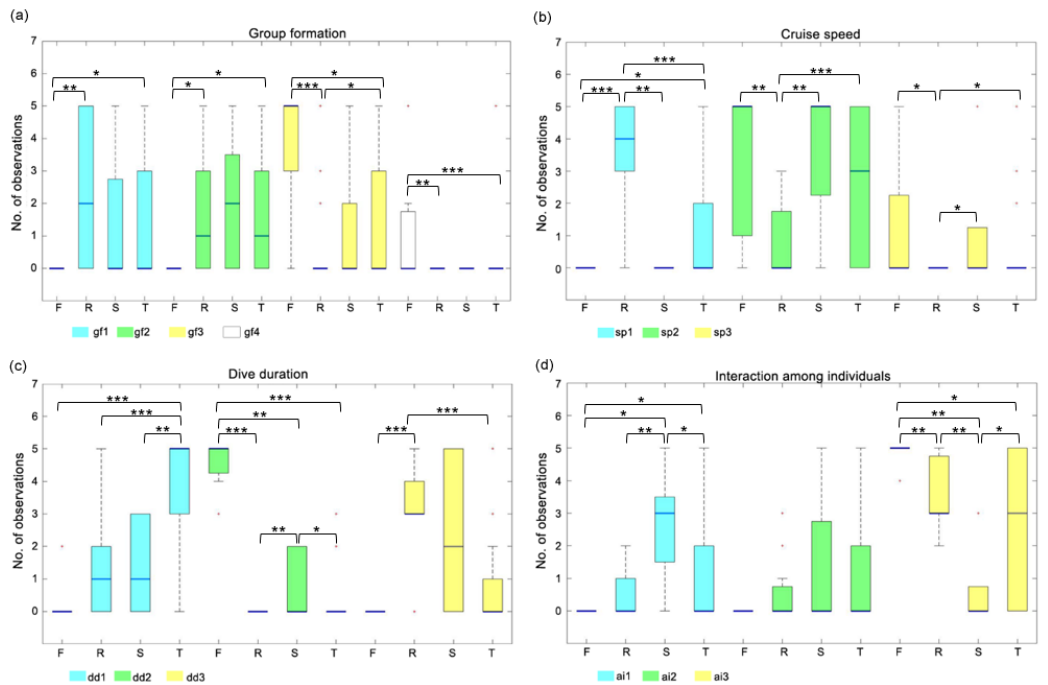
Figure 3. Box plot of the number of observations for each group composition variables: ( a ) group formation (gf), ( b ) cruise speed (sp), ( c ) dive duration (dd) and ( d ) interaction between animals (ai) considering each activity state. The blue bold line is the median value; box limits are quartiles; whiskers represent minimum and maximum values and small red points identify outliers. Significant differences found are reported and the significance level is indicated by asterisks: * p- value < 0.05; ** p- value < 0.01; *** p -value < 0.001. Table 3. Results of Mann – Whitney test (U) performed under the null hypothesis that group for- mation (gf), cruising speed (sp), dive duration (dd) and interaction among individuals (ai) were not significantly different between activity states. p - and U-values were reported. Significant values were reported in bold and asterisks indicate the significance level: * p- value < 0.05; ** p- value < 0.01; *** p -value < 0.001.